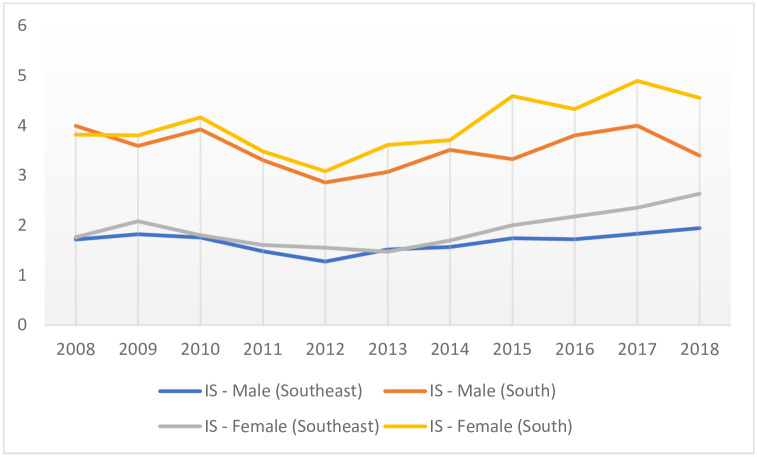
Temporal trend of the incidence of hospitalization (x100,000 inhabitants) due to ischemic stroke, stratified by gender in developed regions of Brazil, 2008–2018.IS—Ischemic Stroke; x-axis: years; y-axis: incidence of hospitalization rates.